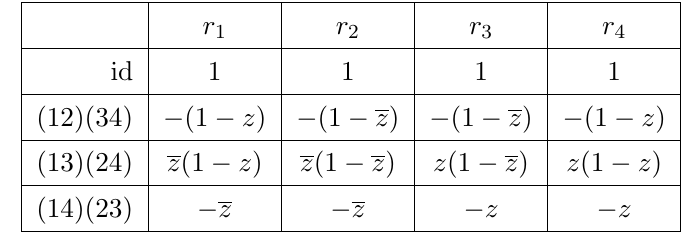
Table 1 . Permutation phases for a 4-point function of identical operators, computed in